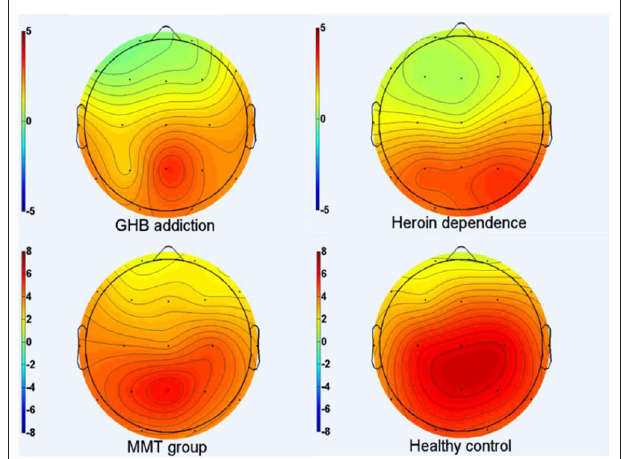
FIGURE 1 | P300 topographic maps. Scalp topographic maps depicting mean P300 amplitudes around the mean latency ± 50 milliseconds for target stimuli of GHB addiction, heroin dependence, MMT and HC